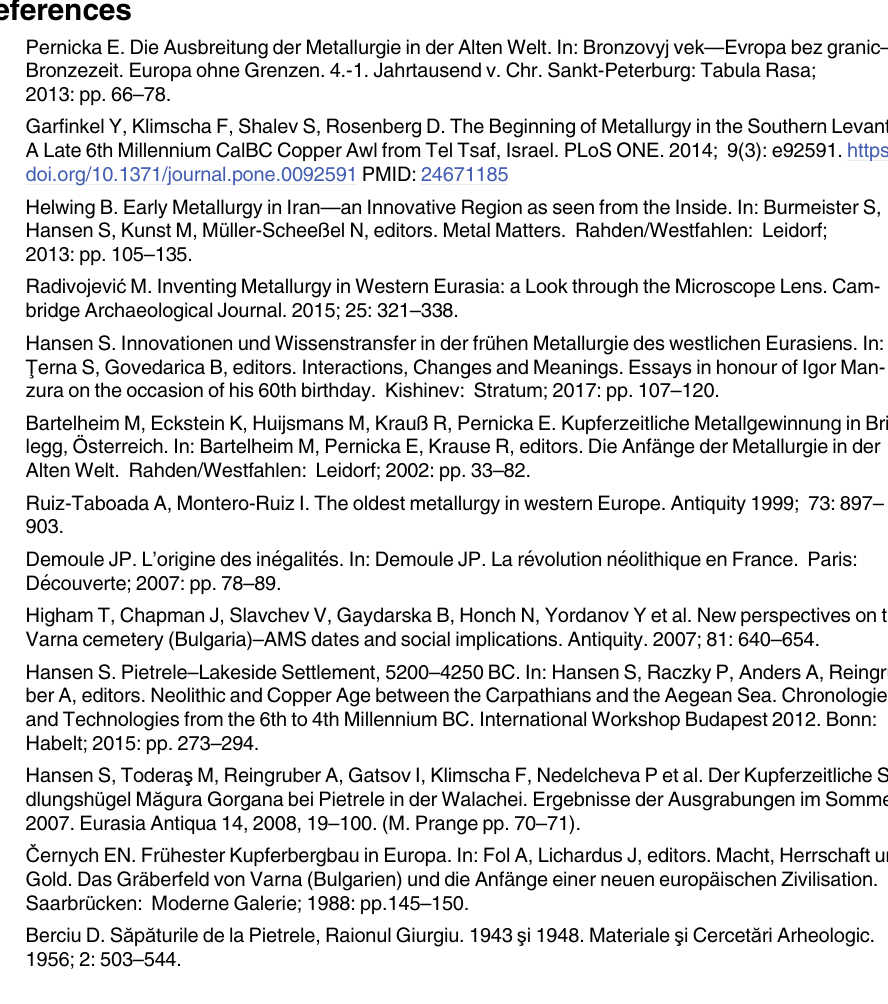
S3 Table. Coefficient of correlation (r 2 ) intercept and slope for oxides and elements by p- XRF. (PDF) S1 Fig. Coefficient of correlation (r 2 ) intercept and slope according to biplots for the com- parison of p-XRF and recommended values (CRM) for the oxides SiO2, TiO2, Al2O3, Fe2O3(T), MnO, MgO, K2O P2O5 and the elements S, Pb, Cu, Zn. (PDF) S1 Supporting Information.